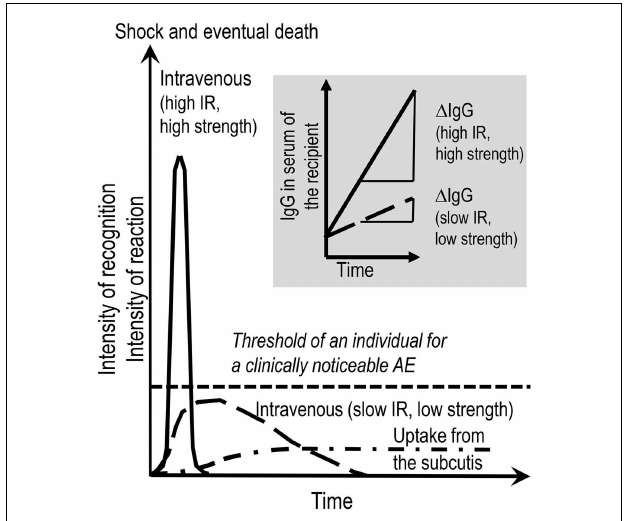
FIGURE 1 | Provoking the dark . AEs to therapeutic IgG concentrates might be evoked by several factors.These are listed in the introductory part and Table 1 . Contemplating on the active ingredient of the concentrates, the administration of the IgG molecules inevitably results in the interactions of the exogenous IgG with the various parts of the immune system of the recipient and vice versa. This interaction in its principle generates an inflammatory condition. A key parameter deciding on the intensity of such a condition is the rate of increase over time of exogenous IgG in the circulation of the recipient. Insert to figure (shadowed): ∆ IgG in the circulation over ∆ time is dependent on the combination of infusion rate (IR) and the strength of the solution applied. Main figure: the mode of application, i.e., intravenous or subcutaneous, are additional factors being decisive for kinetics and the area under the curve of generation of pro-inflammatory mediators and for passing the individual threshold (short-dashed line) for a clinically noticeable AE.The threshold in turn depends on eventually exiting risk factors form the patient side. Although the area under the curve might be the same for low (long-dashed line) and high (solid line) IRs, at high IR, the system might not be able to cope with the extent of reactions. At low IR (long-dashed line), all the events might remain below the threshold of clinically observable AE. Subcutaneously applied IgG concentrate reaches the circulation slowly and systemic AEs are less frequent than with IVIG. In contrast, local mild to moderate AEs are more frequent with